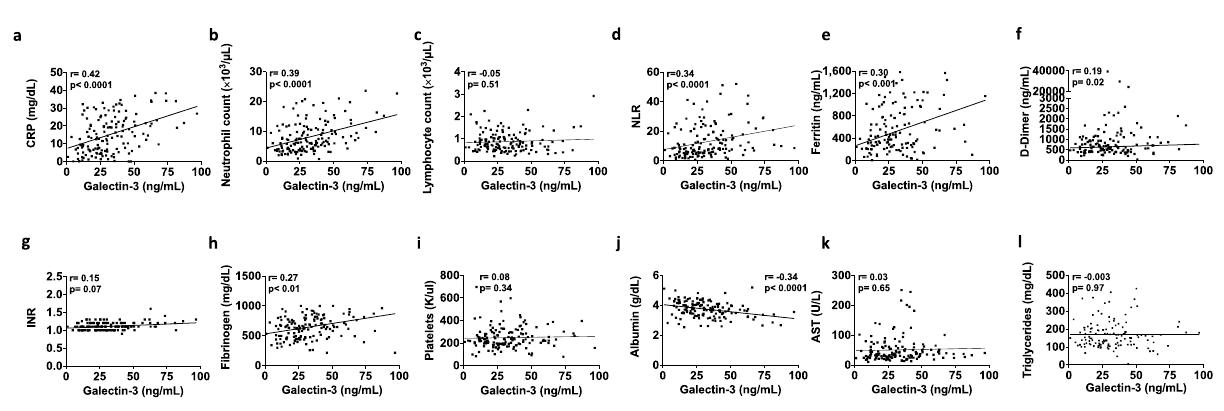
Figure 2. Galectin-3 correlates with inflammatory markers in COVID-19 patients. Spearman correlations show significant associations between galectin-3 and commonly measured inflammatory markers in SARS-CoV-2 infected patients. ( a ) CRP, ( b ) Neutrophil count, ( c ) Lymphocyte count, ( d ) NLR, ( e ) Ferritin, ( f ) D-dimer, ( g ) INR, ( h ) Fibrinogen, ( i ) Platelets, ( j ) Albumin, ( k ) AST and ( l )